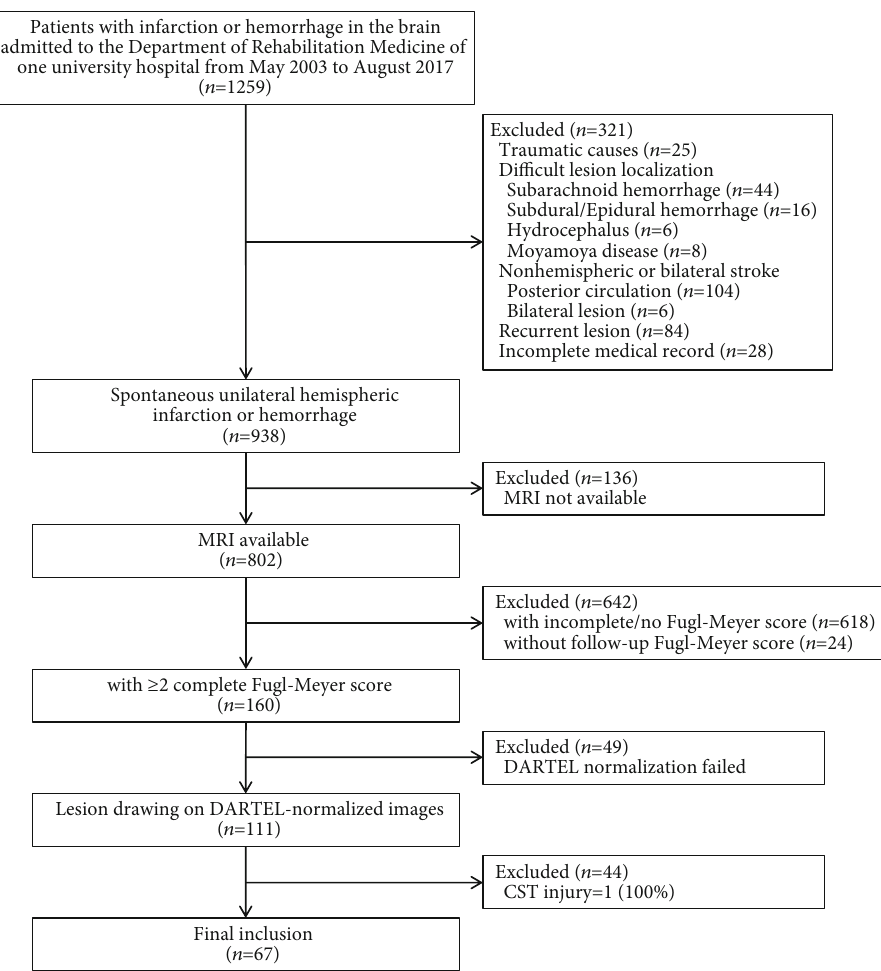
Figure 1: Flowchart of the study procedure. MRI: magnetic resonance imaging; DARTEL: Di ff eomorphic Anatomical Registration Through Exponentiated Lie algebra; CST: corticospinal tract. Table 1: Demographic and clinical characteristics of the